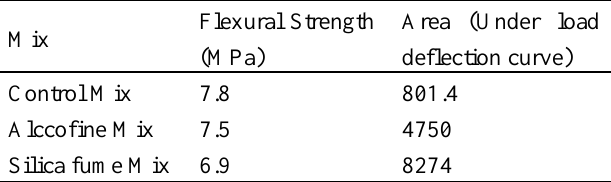
Flexural strength and area under load deflection curve .